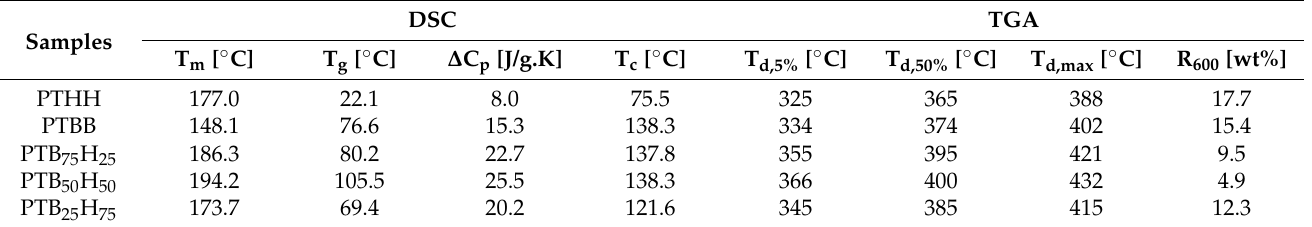
Thermal characterization of poly(hexylene